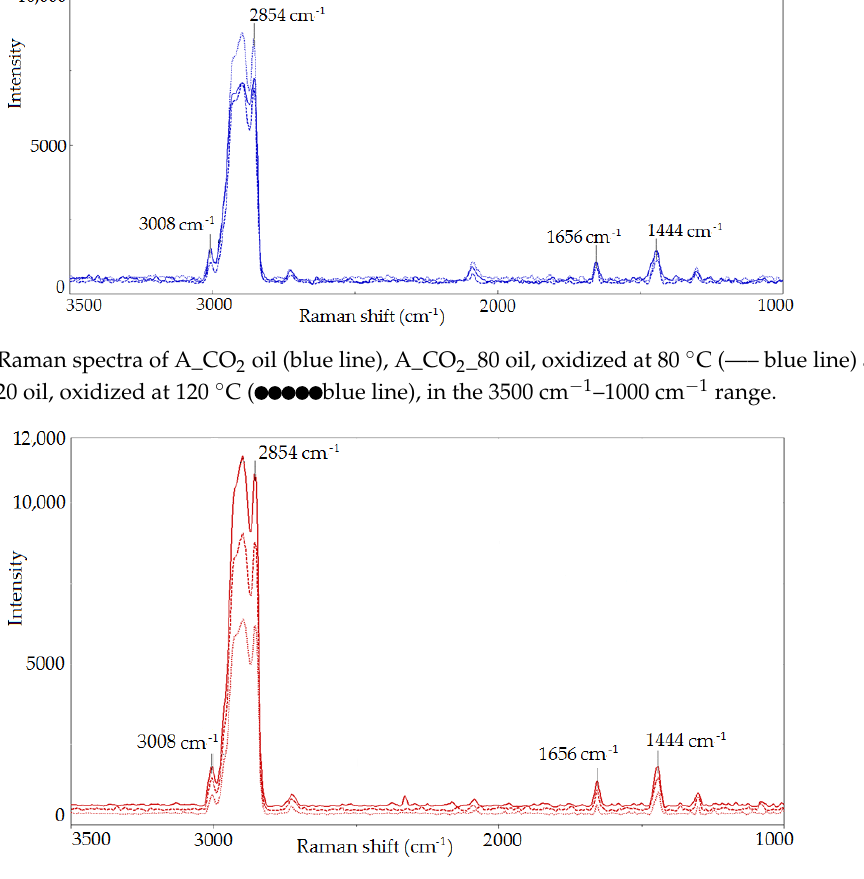
Figure 5. Raman spectra of A_O 2 oil (red line), A_O 2 _80 oil, oxidized at 80 °C (----- red line) and A_O 2 _120 oil, oxidized at 120 °C (••••• red line), in the 3500 cm −1 –1000 cm −1 range.